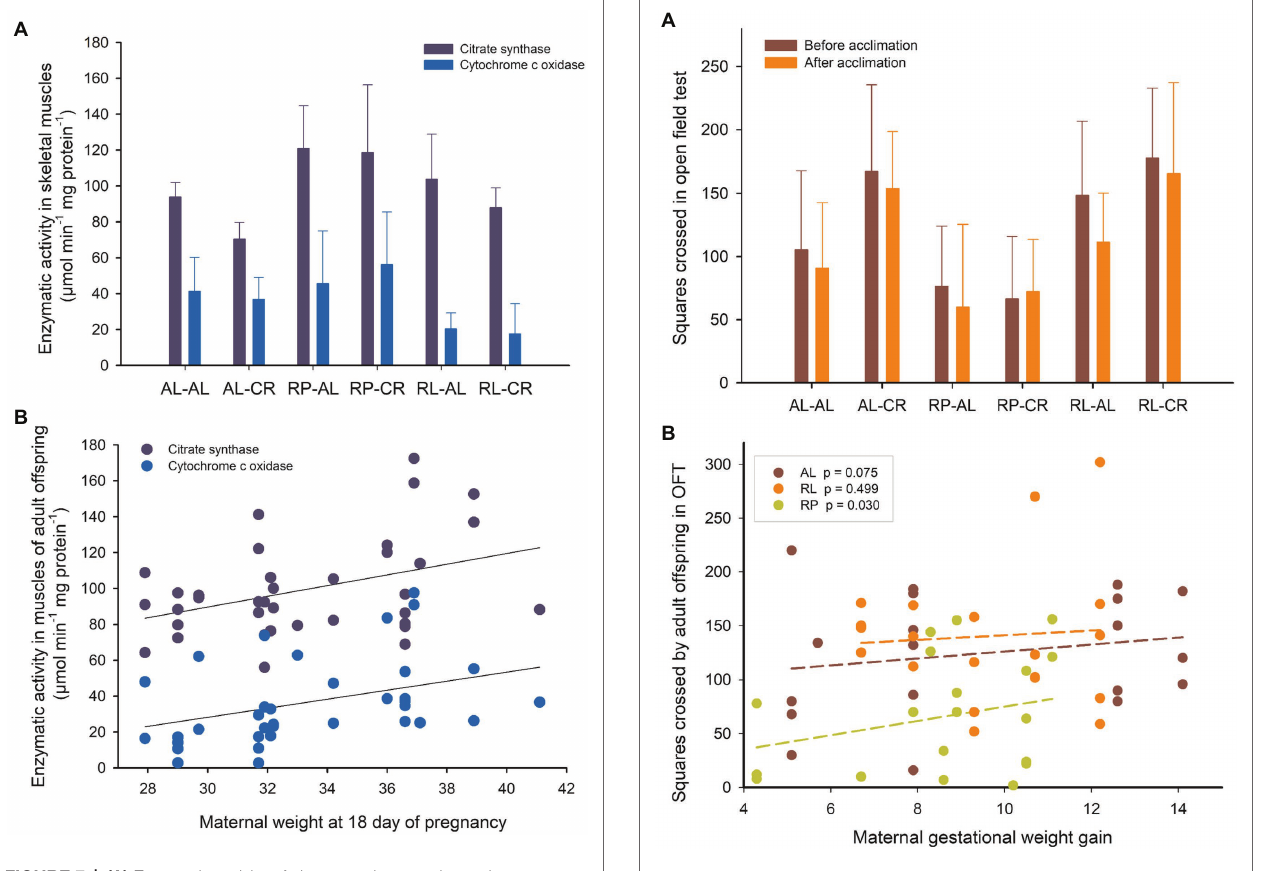
FIGURE 8 | (A) Squares crossed in the open field test before and after acclimation, in adult male BALB/c mice, from six groups of perinatal and adult food availability. (B) Pooled data of squares crossed in the open field test (before acclimation to adult CR) and the body weight gain of their mothers at the end of pregnancy. See statistical results in main